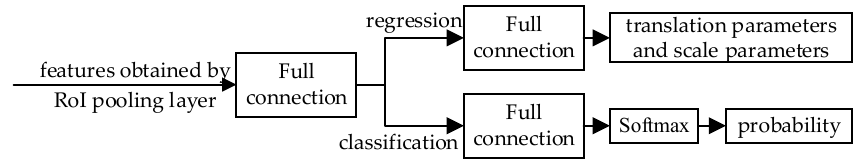
Figure 6. Operating principle of object detection layer.